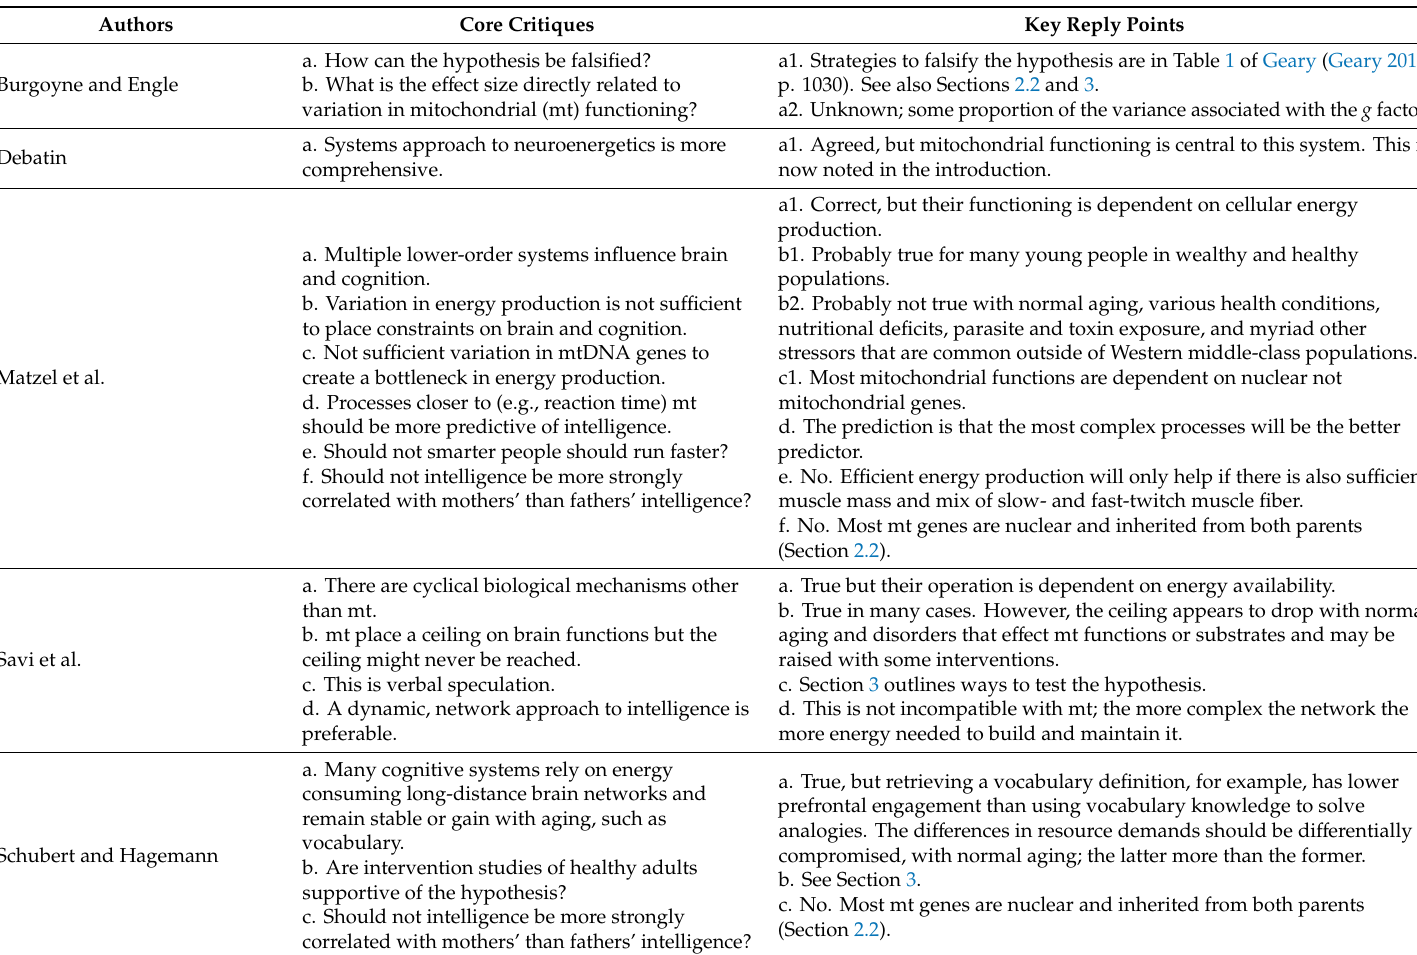
Table 1. Core critiques and summary of key